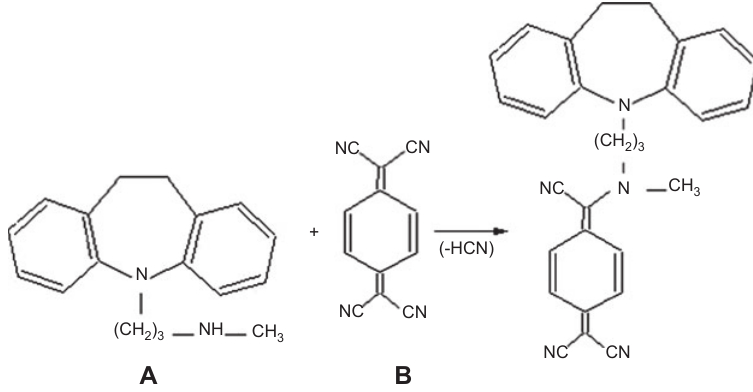
Figure 1 The proposed reaction between desipramine (A) and TCNQ